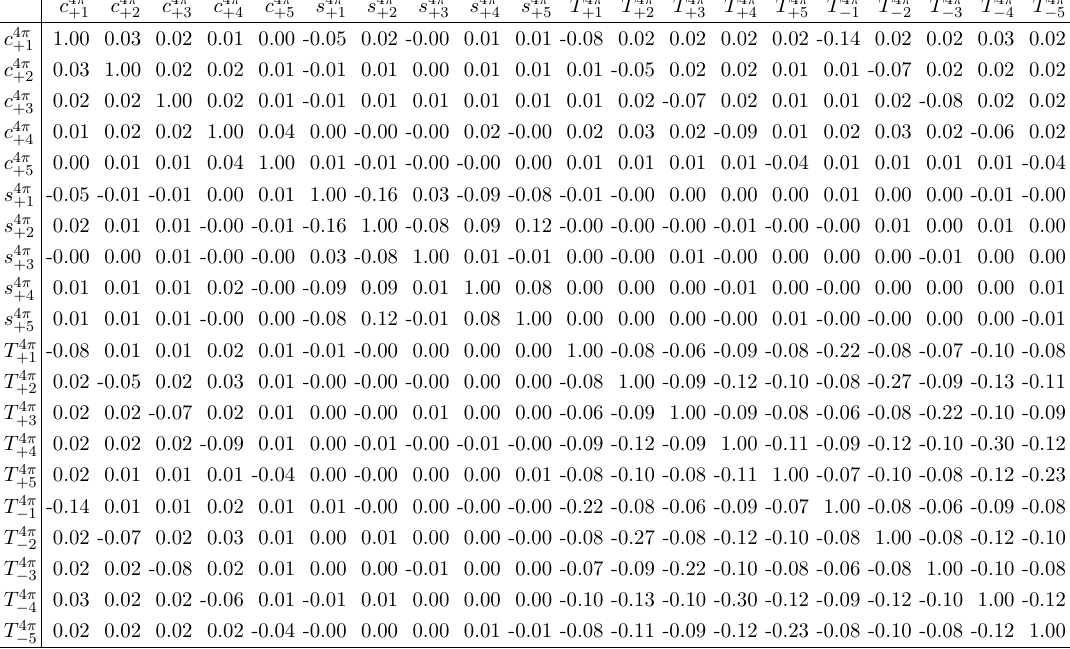
Variable (cid:1) (cid:14) 4 (cid:25) binning statistical correlations p